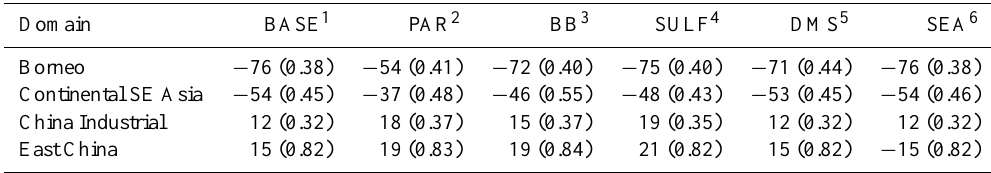
Table 8. Mean model percentage error (correlation r ) compared to MODIS AOD measurements. Domain